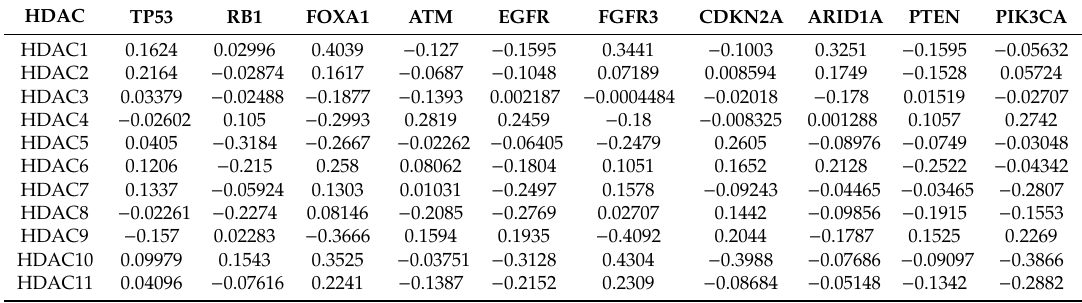
Table A1. Spearman correlation values for HDAC genes and commonly mutated driver genes in BC.